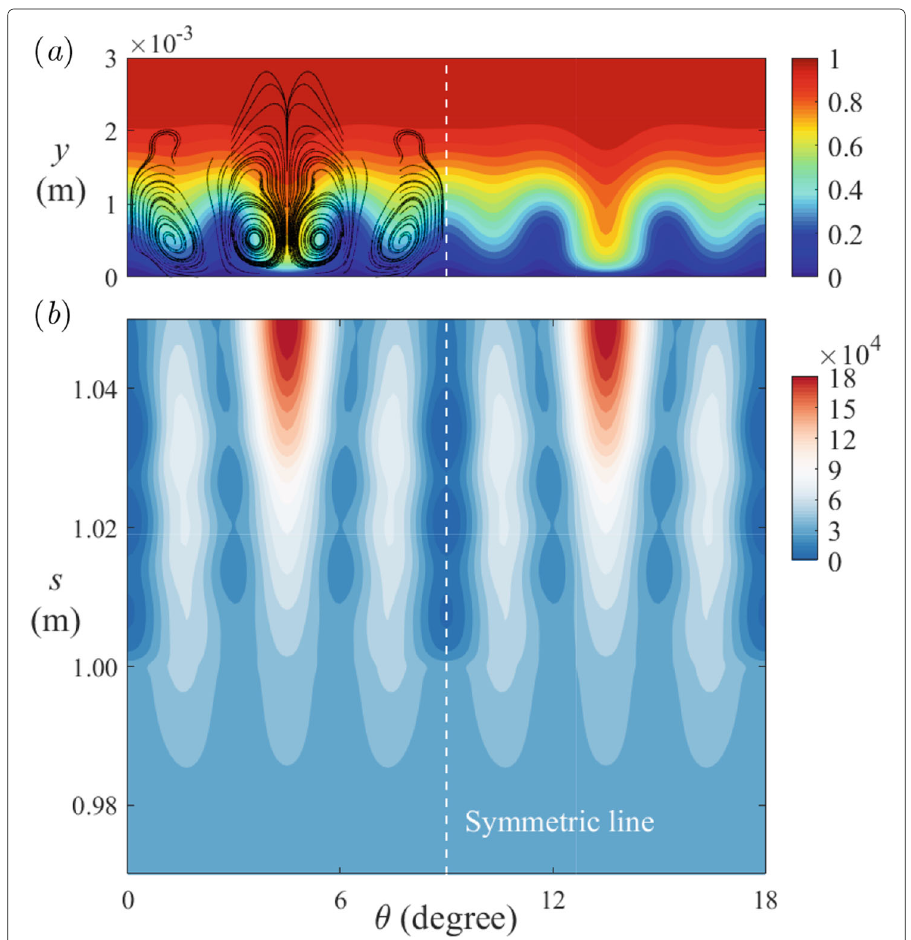
Fig. 8 Contours of the time-averaged flow: ( a ) the streamwise velocity ¯ u / U ∞ at s = 1.05m with the black lines the disturbance streamlines in the y − θ plane and ( b ) the wall-normal gradient ∂ ¯ T /( T ∞ ∂ y ) at the